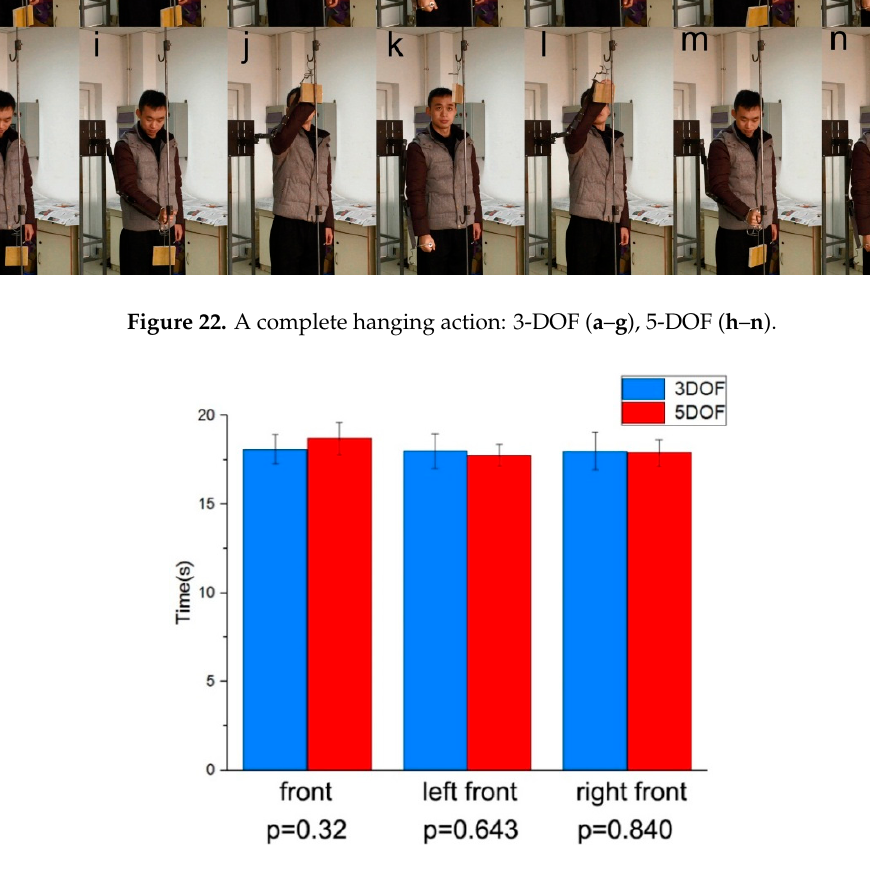
Figure 23. Statistical analysis results of the action completion time.